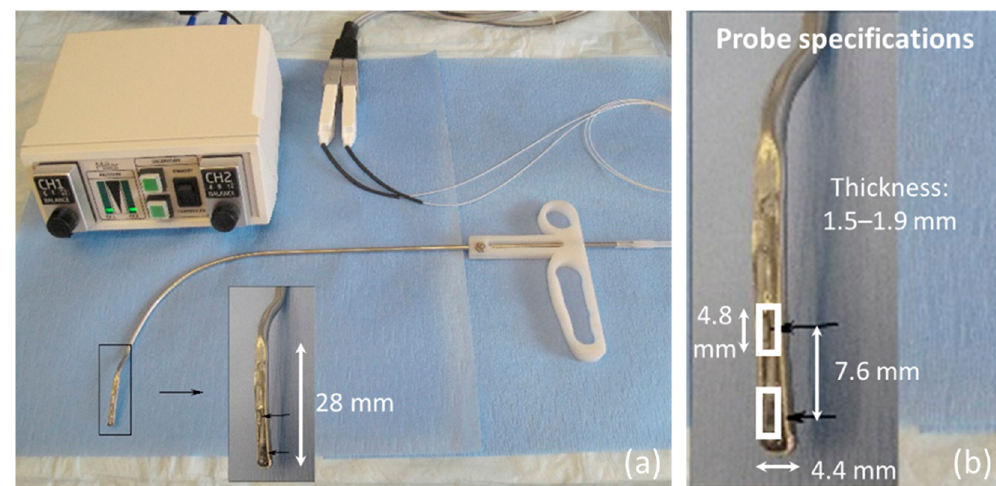
Figure 2. In vivo intraglottal/subglottal pressure (ISP) probe with two pressure sensors at the probe tip to simultaneously measure intraglottal and subglottal pressure during phonation, ( a ) ISP probe with a Ford injector-like handle and two- channel signal conditioning electronics, ( b ) zoomed-in view of the ISP probe tip showing dimensions of the two in-line pressure sensors. From [13].